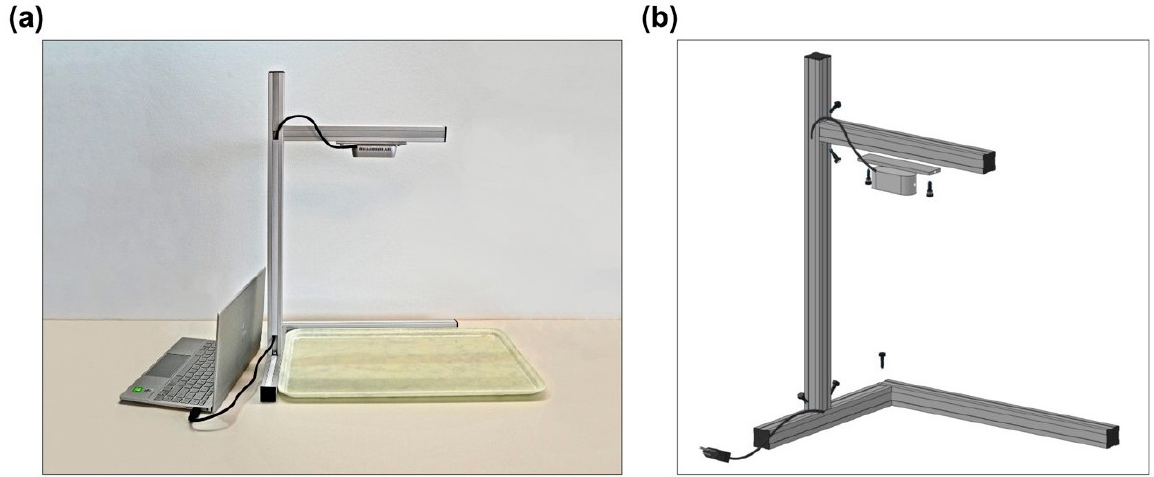
Figure 1. Standardised mount for capturing images by the RGB-D camera; ( a ) setup for image capture—the RGB-D camera is connected to a laptop and on top of an empty tray; ( b ) expanded view of the mount showing the mechanical parts of the mount for the RGB-D camera.